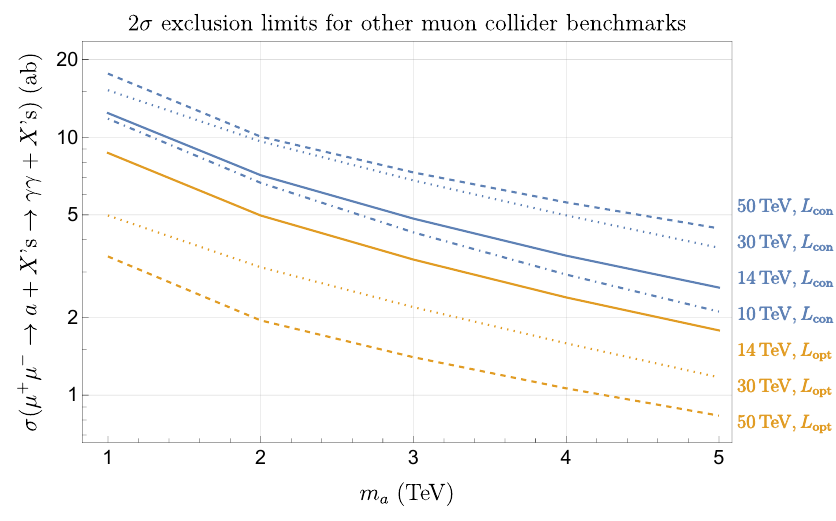
Figure 8 . 2 σ limits on σ ( µ + µ − → a + X ’s → γγ + X ’s ) at various muon collider benchmarks.